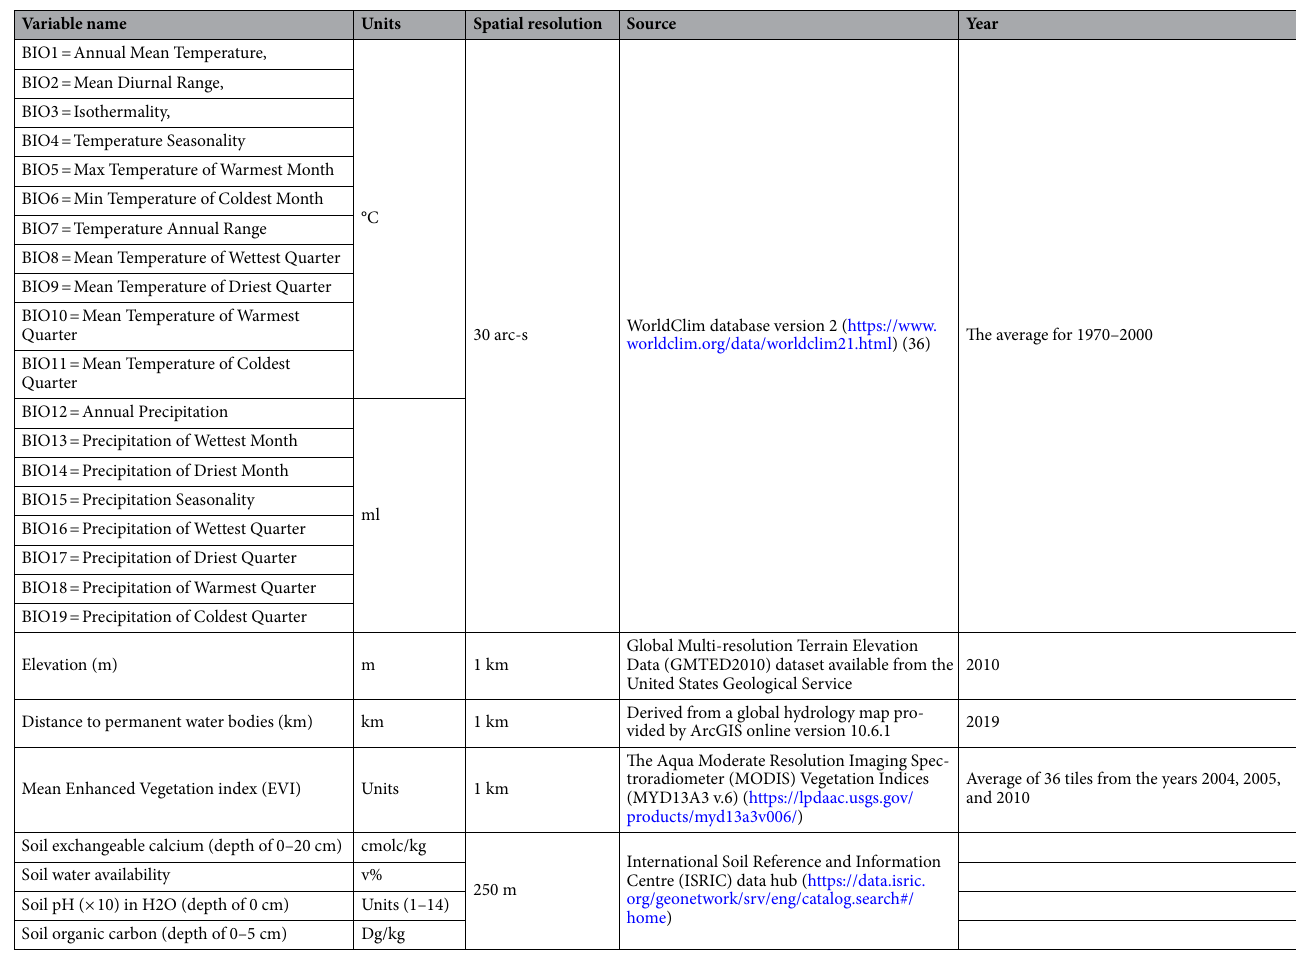
Table 1. Summary of the environmental variables